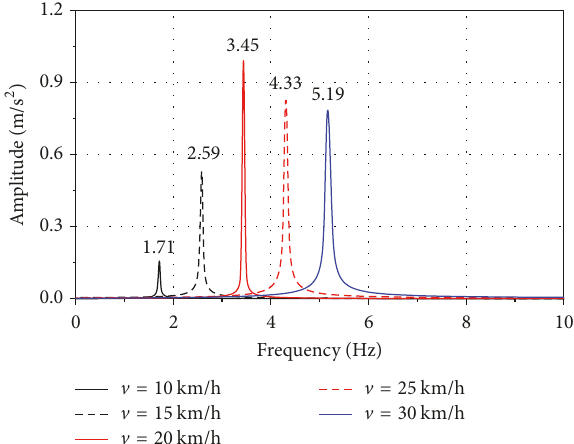
Figure 11: The frequency spectrum of the simulated acceleration at different speeds.